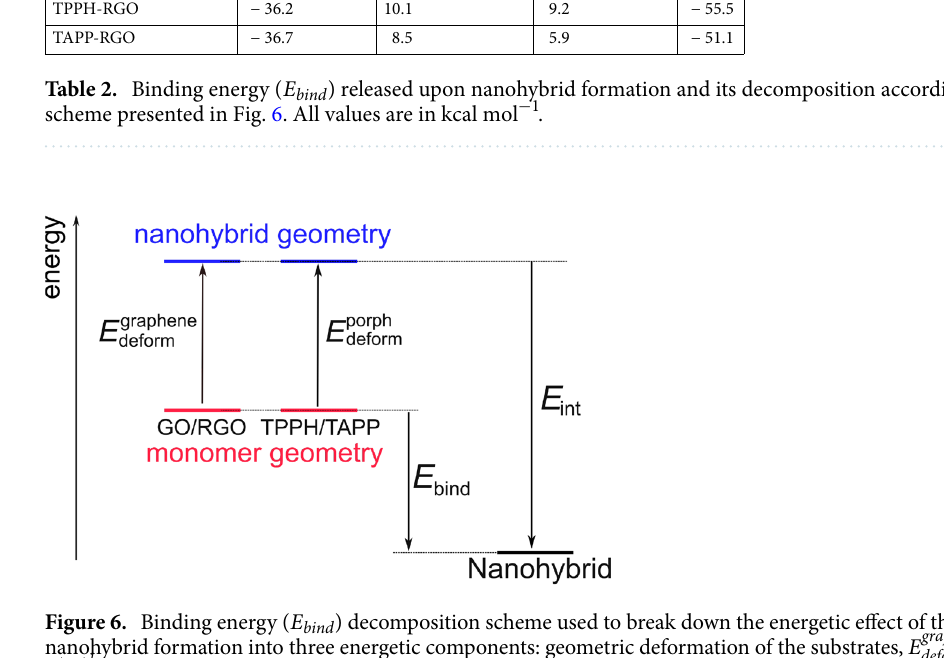
graphene deform and E int